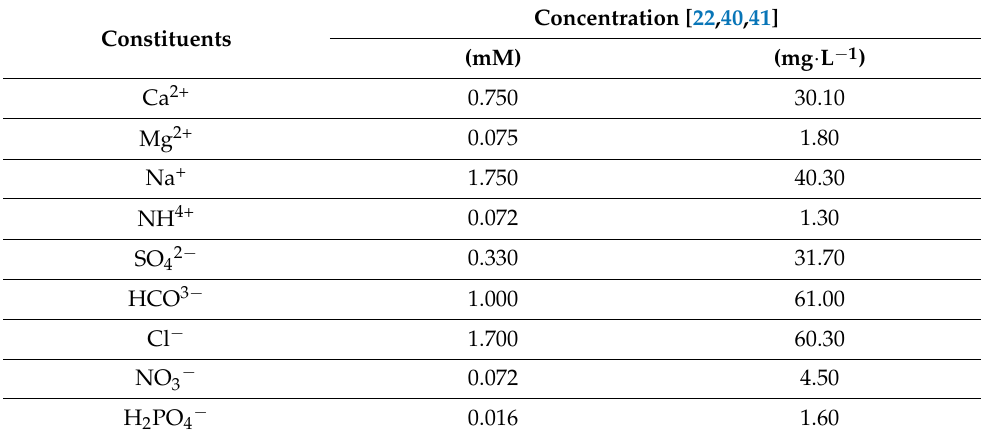
Table 1. Clean synthetic stormwater composition.